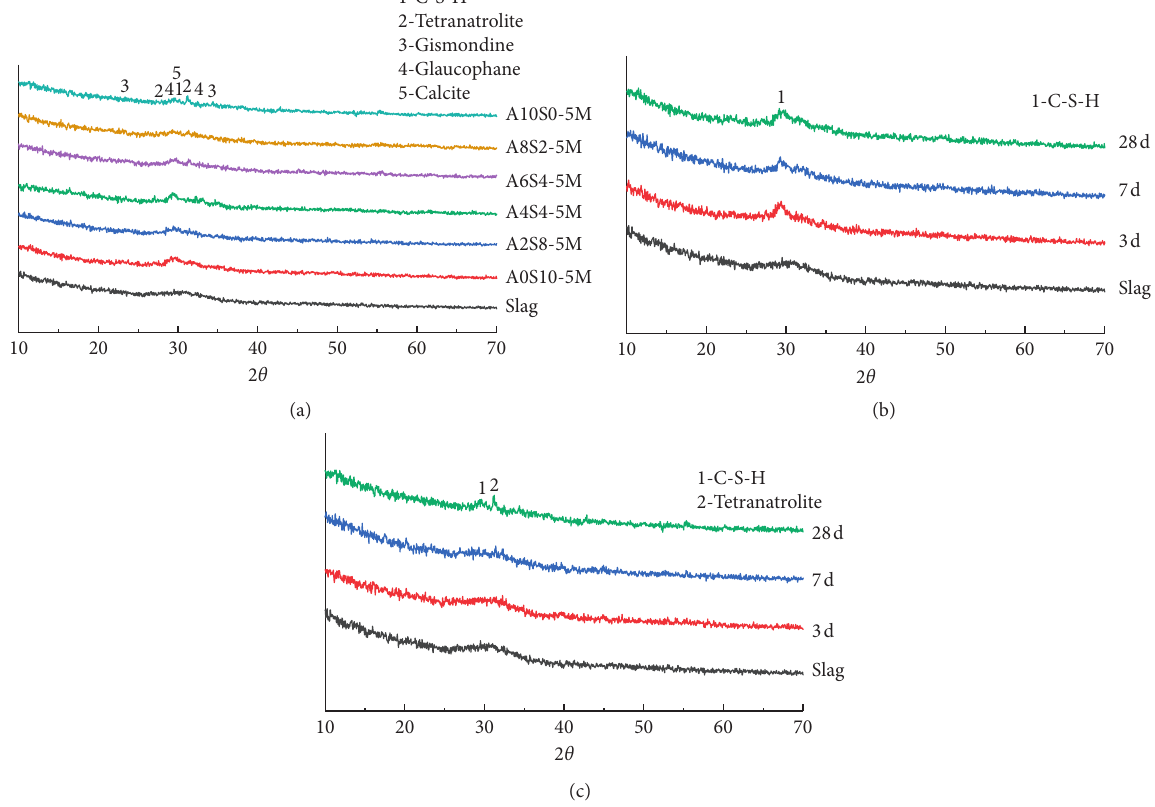
Figure 6: XRD images of AAS and raw slag. (a) Different NaAlO 2 dosages at 28d curing time and raw slag; (b) A0S10-5M at 3, 7, and 28d curing time and raw slag; and (c) A10S0-5M at 3, 7, and 28d curing time and raw